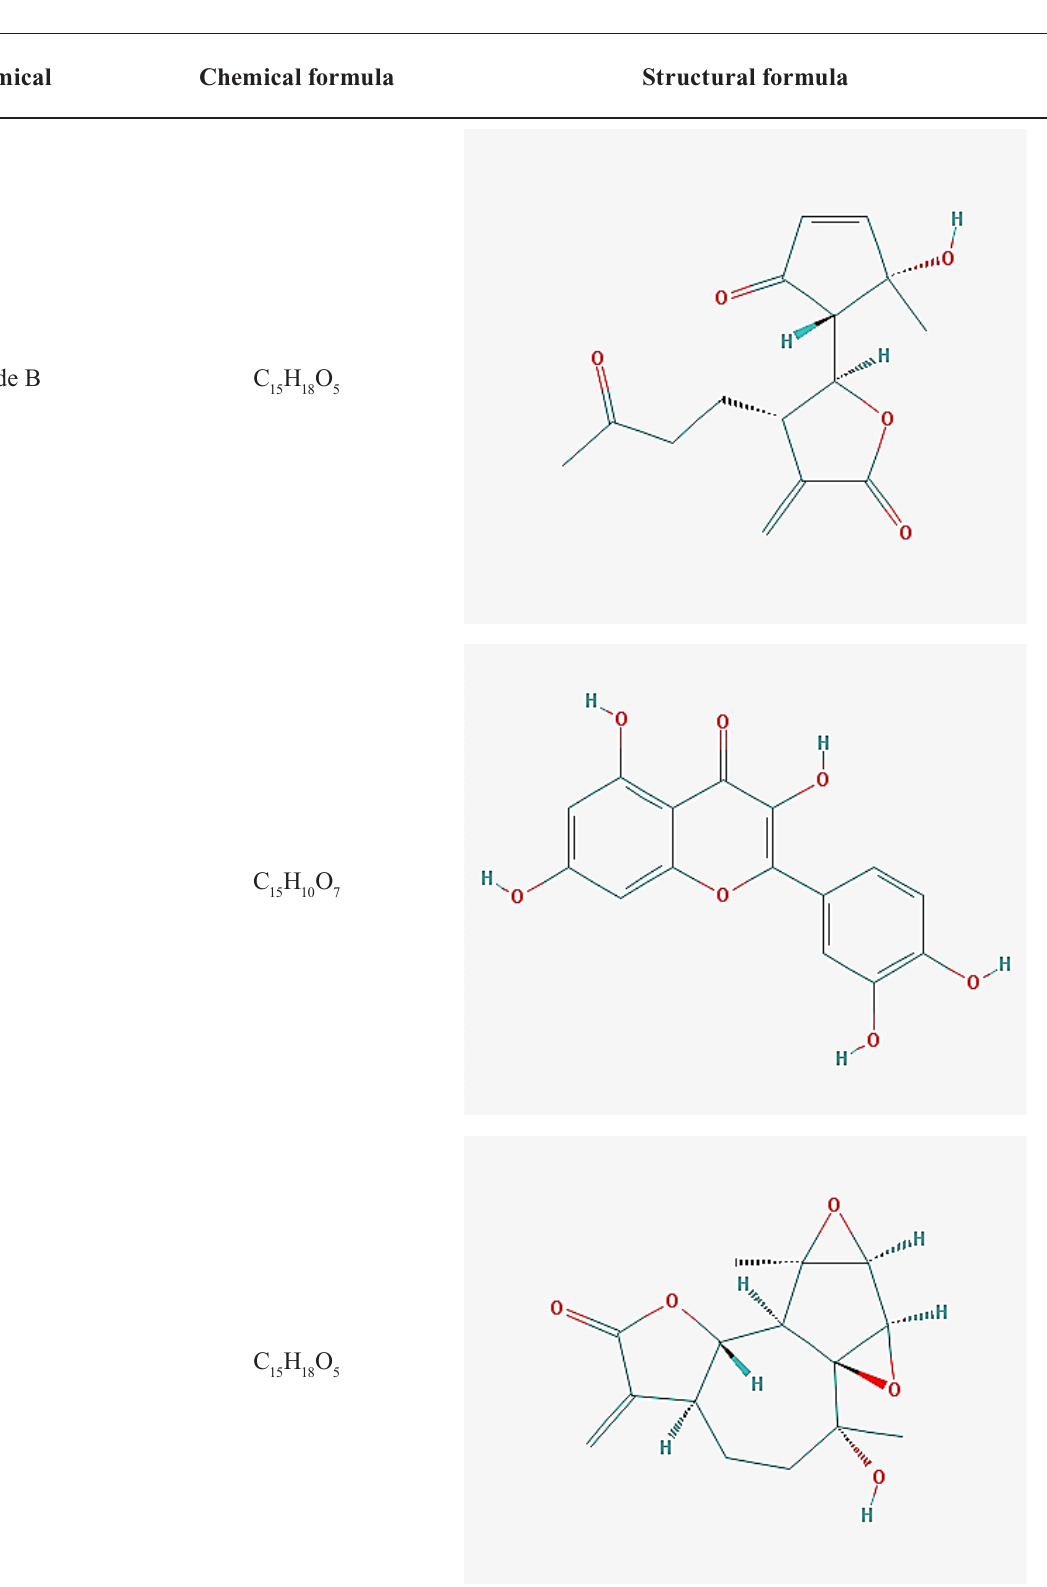
TABLE I - P hytochemicals from Tanacetum parthenium and Silybum marianum